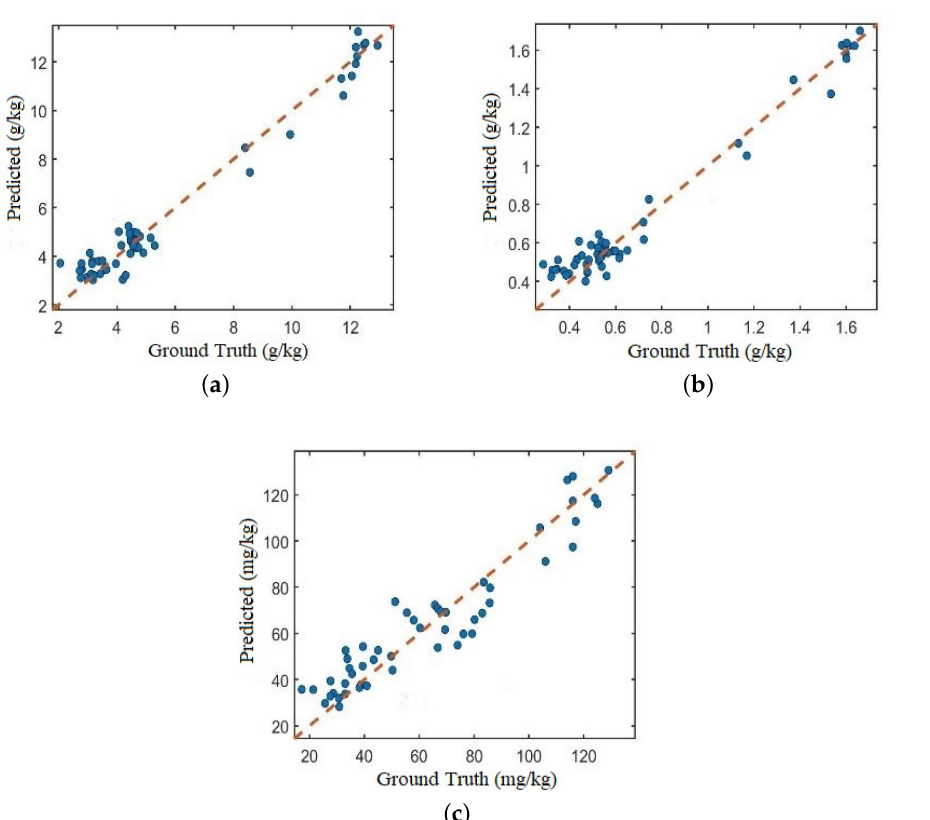
Figure 9. Actual vs Predicted values of Proposed framework ( a ) Total Carbon ( b ) Total Nitrogen ( c ) Alkaline